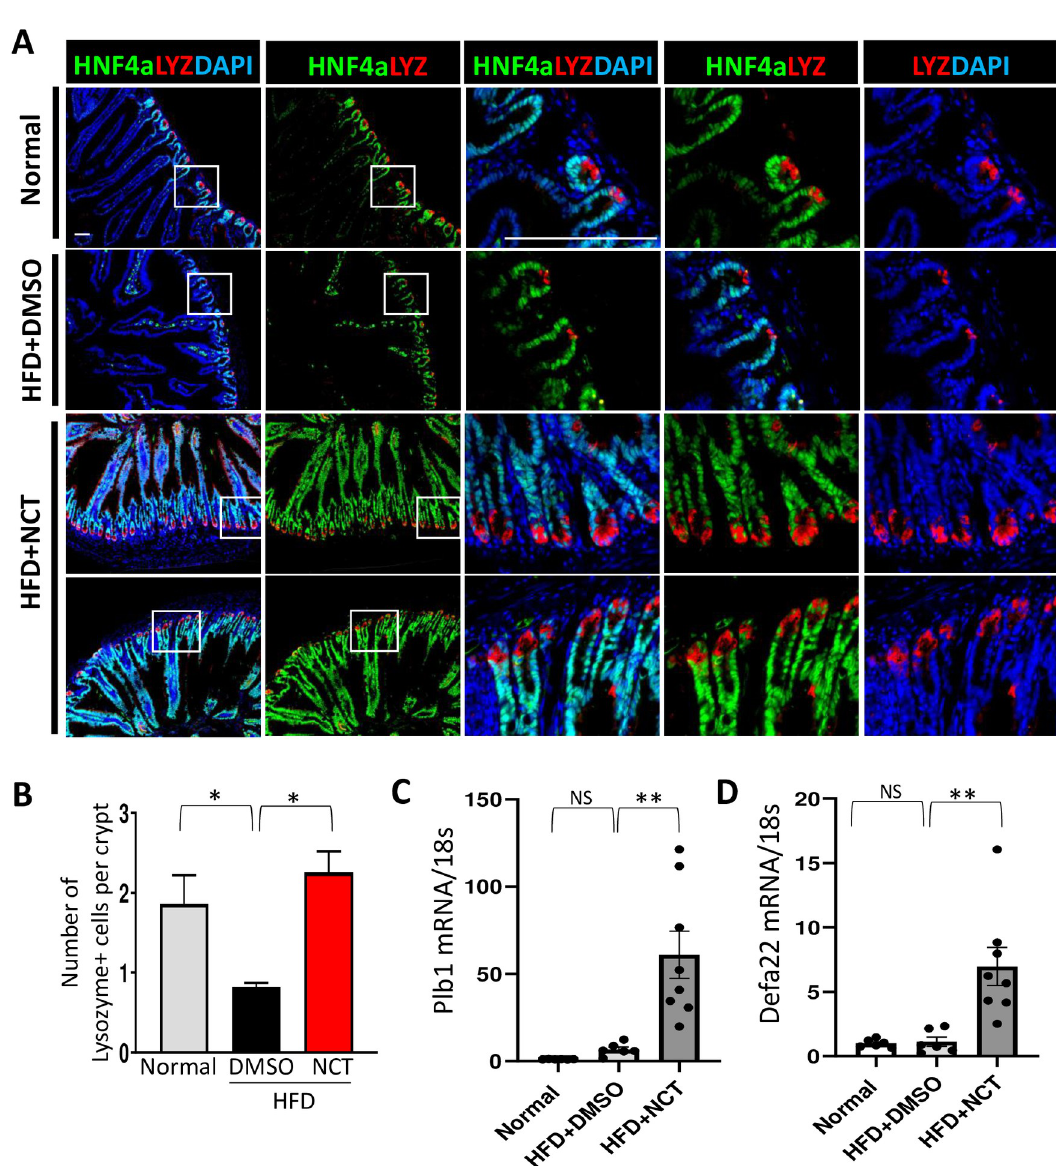
Fig 4. NCT induced recovery of Paneth cells in intestine. A . Frozen sections of intestine from the mice described in Fig 1 were stained with HNF4 α (green), Lysozyme (red) and DAPI (blue) in mice fed normal diet, HFD+DMSO or HFD+NCT. White box indicates high power view in adjacent panel. B. Quantification of the number of lysozyme-positive cells per intestinal crypt (HFD+DMSO vs. Normal or HFD+NCT). C, D . qPCR analysis in mouse small intestine of Plb1 and Defa22 mRNA expression normalized with 18s rRNA (N = 6–8). NS = non-significant, � p < 0.05, �� p < 0.01. Values represent the mean ± SE of 3–7 mice. Scale bar = 200 μ